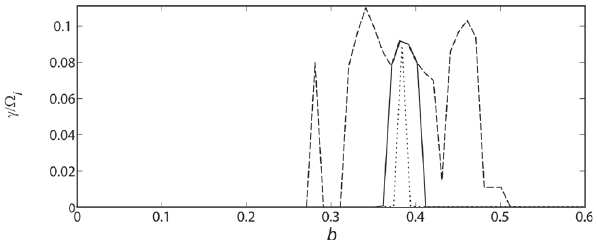
Fig. 4. Behavior of the IEDD solutions shown in Fig. 3 for ω r = 0 . 94 with varying temperature ratio τ : the dashed line refers to τ = 0 . 5, solid line to τ = 1, and dotted line to τ = 1 .